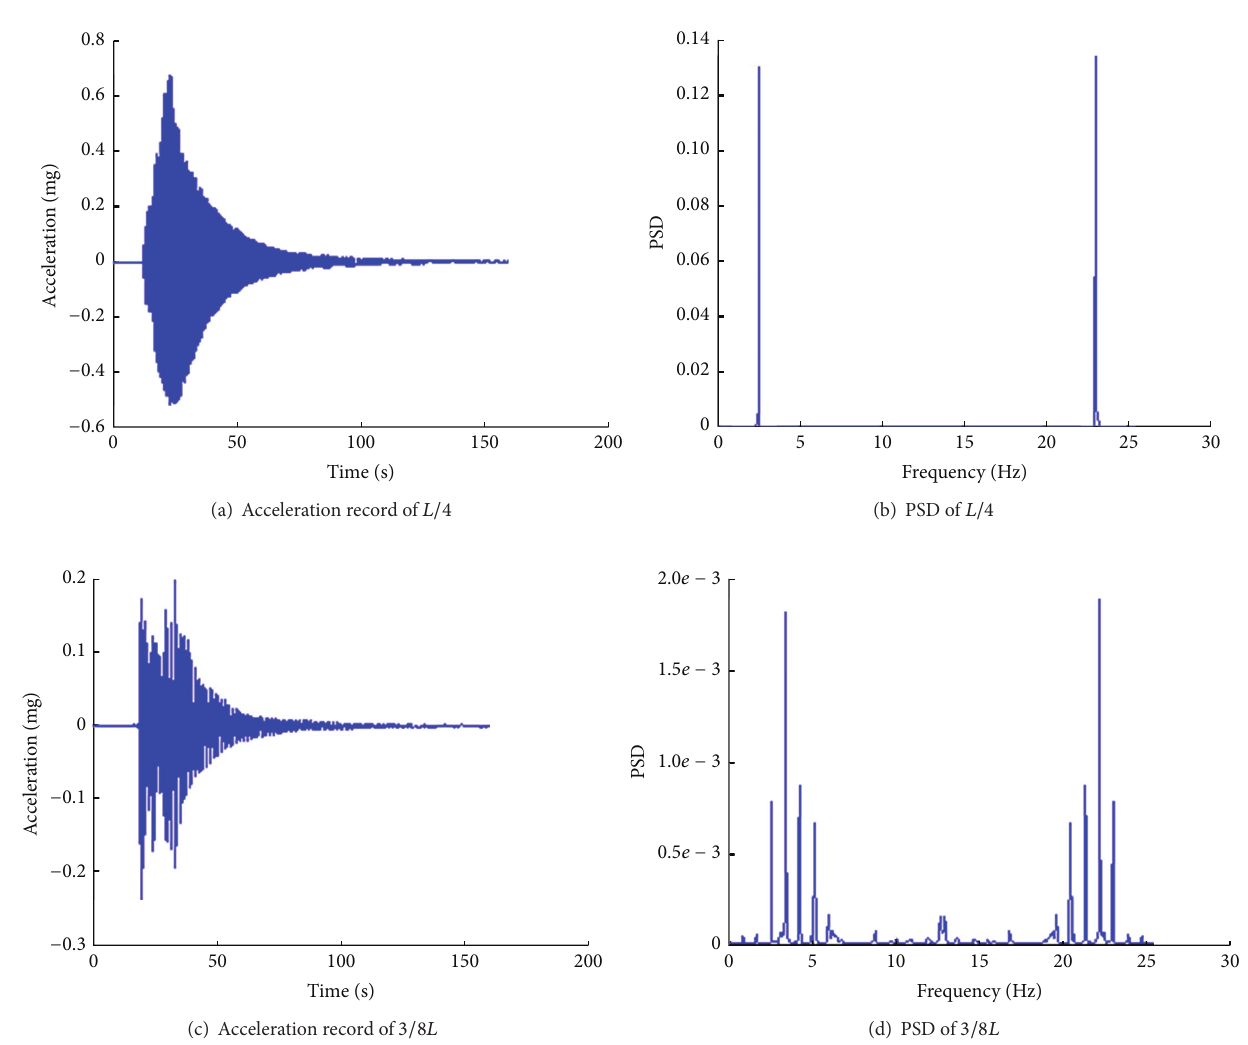
Figure 11: Acceleration record and PSD of full-scale cable